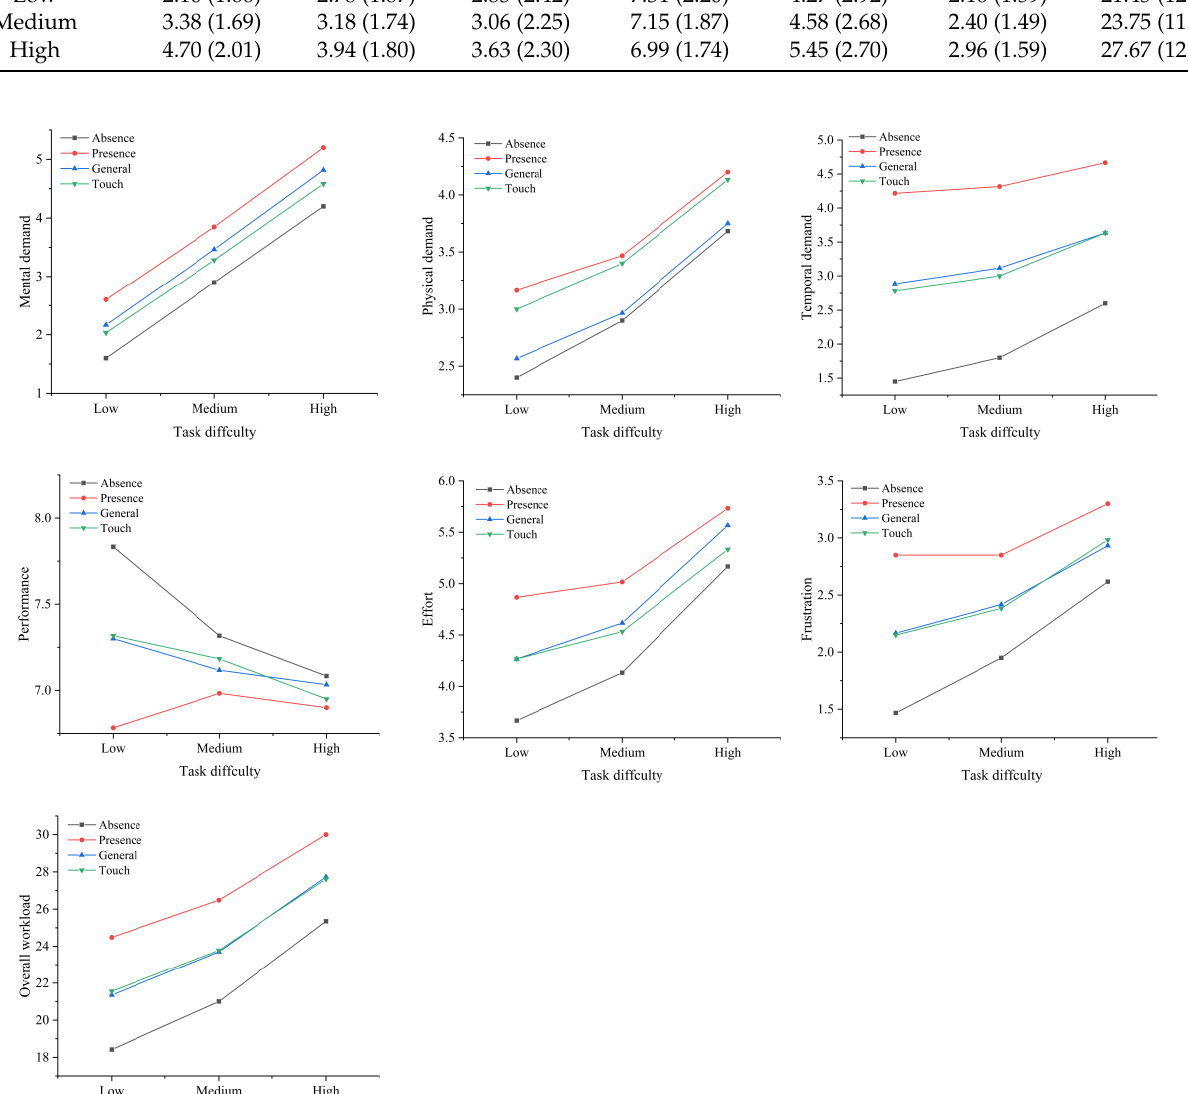
Figure 10. Effects of time pressure, screen type, and task difficulty on the perceived workload and its six